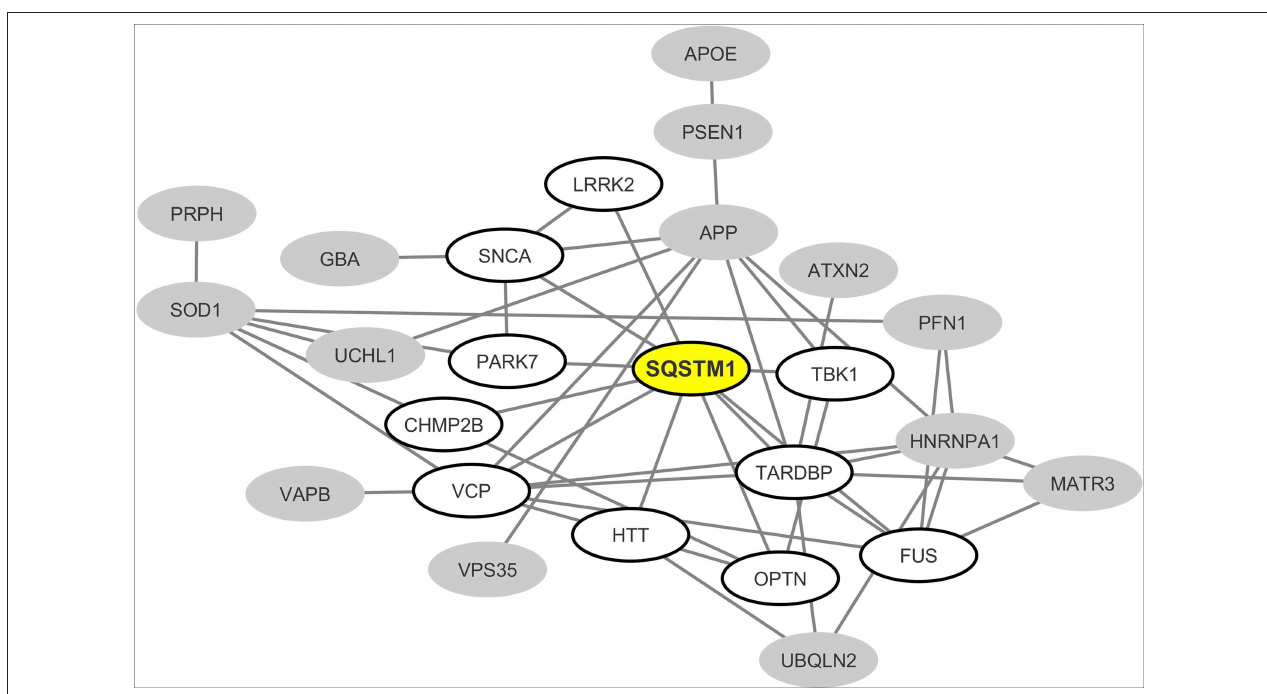
FIGURE 3 | Mapping of the protein-protein interaction network linking common neurodegeneration-associated proteins which are expressed in human B lymphocytes. A survey of the human proteome was performed by querying the protein-protein interaction database BioGRID ( 38). Each node represents a protein indicated by the corresponding gene symbol and each edge represents an experimentally-demonstrated protein-protein interaction. In this network, the “SQSTM1” (Sequestosome-1) node, highlighted in yellow, exhibits the highest degree (i.e., the highest number of direct interactors). White nodes correspond to the first-shell partners of SQSTM1 in human B lymphocytes. Gray nodes are expressed by B lymphocytes but are not direct interactors of